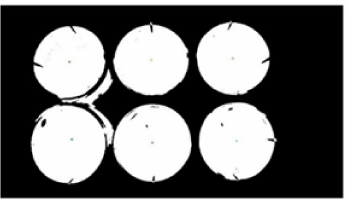
Figure 4. Binary image after edge